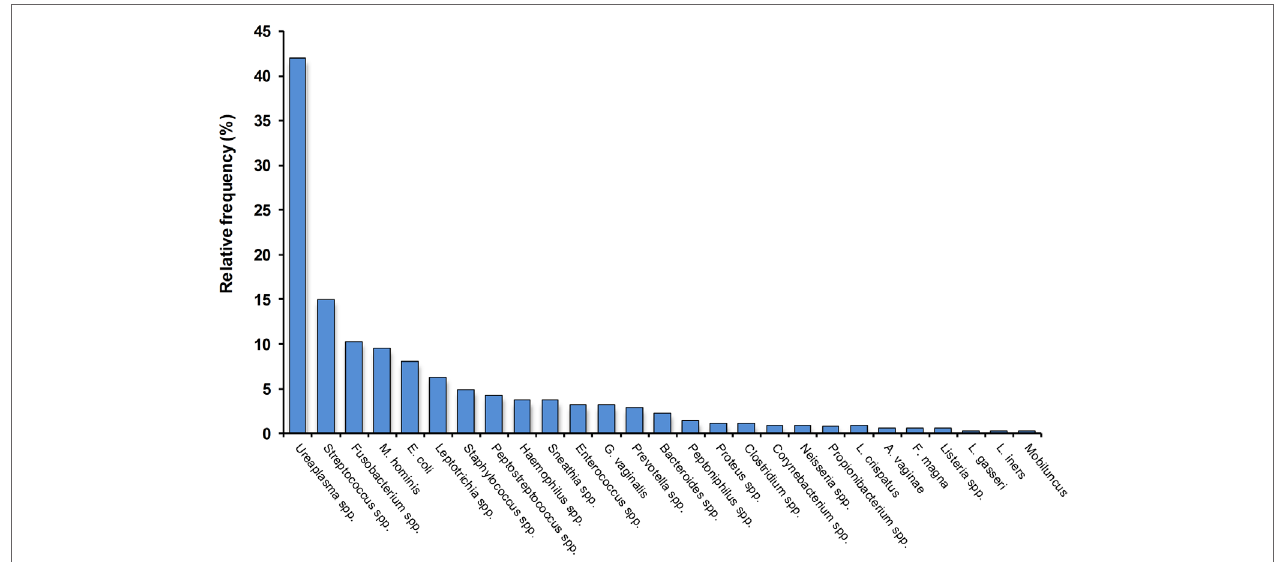
FiGURe 1 | Relative frequency of colonization by different bacteria of the amniotic cavity in preterm deliveries with intact membranes and intra- amniotic infection . Note that more than one bacterium are frequently detected. Data, compiled from Ref. (16–19), are indicative only and will vary according to clinical and demographic characteristics, plus methodological